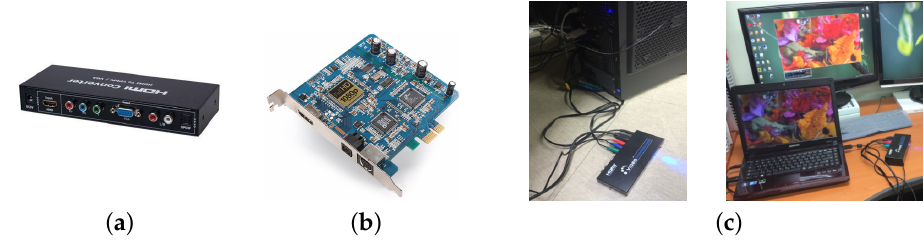
Figure 5. Converters for DA-AD conversion. ( a ) Fosmon HDMI to component video converter box, ( b ) skyHD captureX HDMI, and ( c ) DA-AD conversion testing environment.